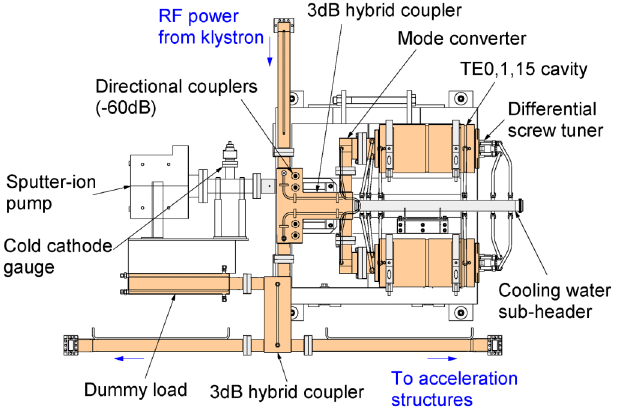
FIG. 6. Schematic of the SLED and surrounding waveguide and vacuum components.